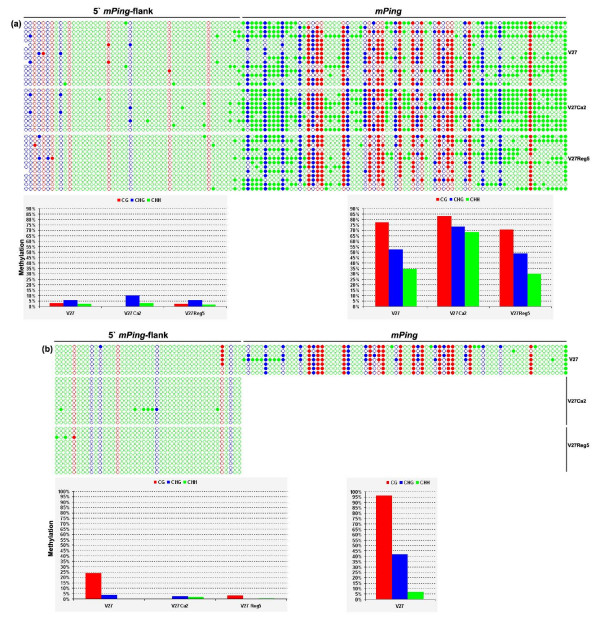
Cytosine methylation maps and collective methylation values (in percentage) for an inactive (immobile) mPing-containing locus (ITDTG8) (a) and an active (excised) mPing-containing locus (ITDTA6) (b) in seed-plant (V27), a pool of calli (V27Ca2) and a regenerated plant (V27Reg5) of cv. V27, determined by genomic bilsulfite sequencing. All three types of cytosines, CG (red circles), CHG (blue circles) and CHH (green circles), at the immediate 5'-flanks and portion of the mPing body-regions were shown in the map. Filled and empty circles denote methylated and unmethylated cytosines, respectively. The red, blue and green columns in the histograms refer to the collective methylation levels (in percentage) respectively of CG, CHG and CHH, at each part (5'-flank or mPing-body) of the two loci for each analyzed plant sample.